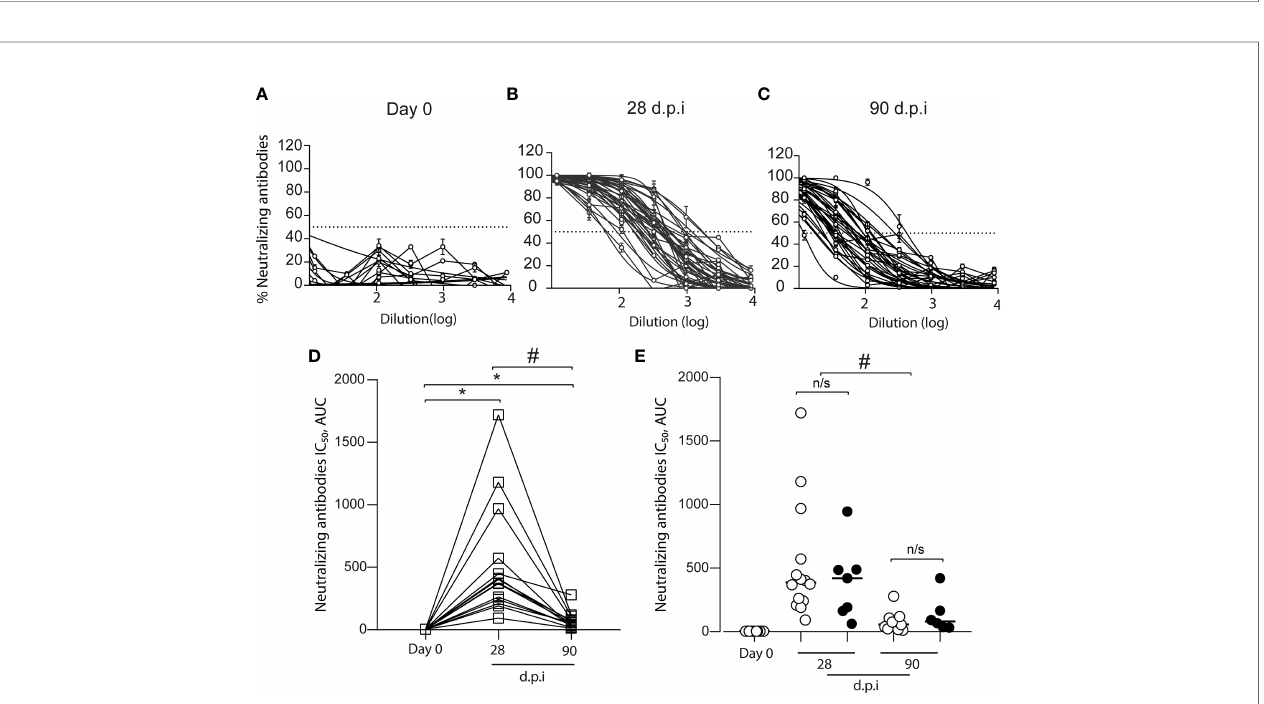
FIGURE 3 | Total anti-S neutralizing antibodies in the plasma of CoronaVac-vaccinated volunteers. The neutralization curves from plasma samples of volunteers were obtained by using a pseudotyped viral particle (HIV-1 – S D 19). Samples were titrated in triplicate at serial threefold dilutions and expressed as percent of neutralization. (A) Total anti-S neutralizing antibodies before vaccination (Day 0). (B) Total anti-S neutralizing antibodies at 28 days after the second immunization (dpi). (C) Total anti-S neutralizing antibodies at 90 dpi (D) IC 50 calculated based on inhibition rates and depicted for each sample obtained from volunteers with a complete follow-up schedule ( □ ) ( n = 15). The data show individual paired values. (E) IC 50 calculated for the total data ( n = 21 volunteers, including those with no complete follow-up schedule) were graphed and shown with median. Open circles ( ○ ): data from (D) Black circles ( (cid:129) ): volunteers with no sample on some of the time-points evaluated. Asterisk (*) represents statistically signi fi cant difference obtained from the comparison against day 0 ( p < 0.05). Hashtag (#) represents statistically signi fi cant difference between 28 dpi and 90 dpi samples. n/s, not signi fi cant ( p <